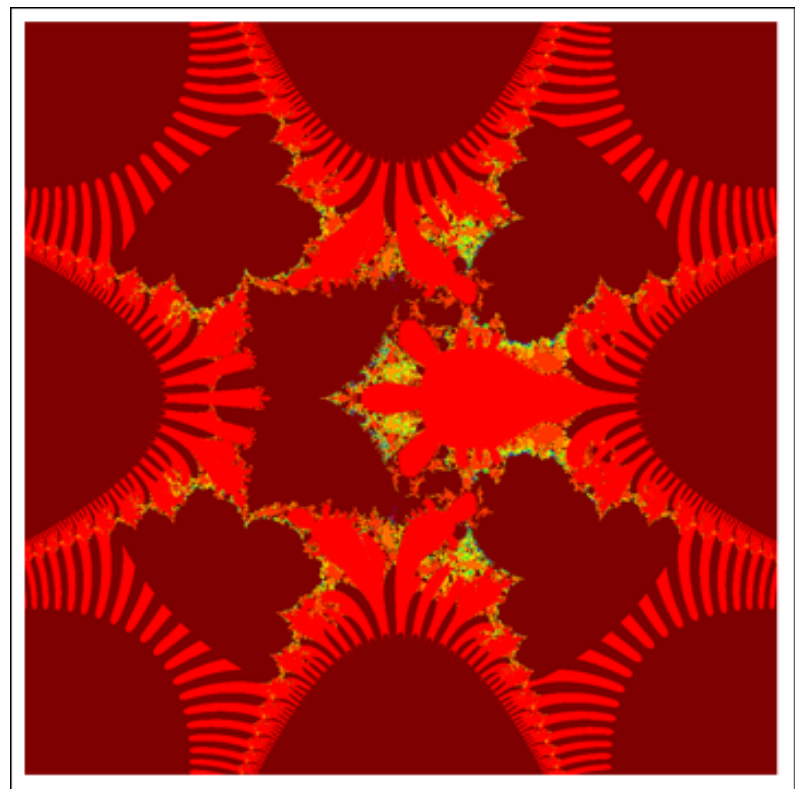
Figure 36. M-set for τ ( z ) = e z 4 + c via DKIS. The image execution time is 858.06